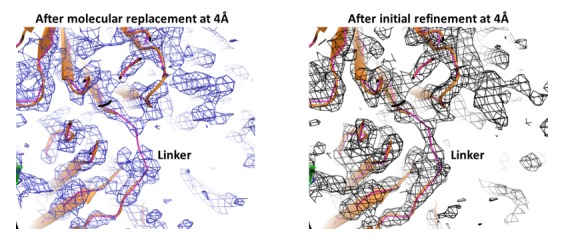
DOI:
http://dx.doi.org/10.7554/eLife.20383.022